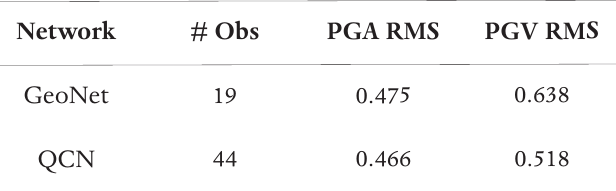
Table 2. RMS scatter for event